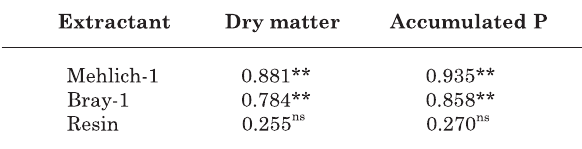
Table 6. Regression equations adjusted to plant P uptake as related to P extracted by Mehlich-1, Bray-1 or resin and properties that reflect the buffering capacity of P in soil